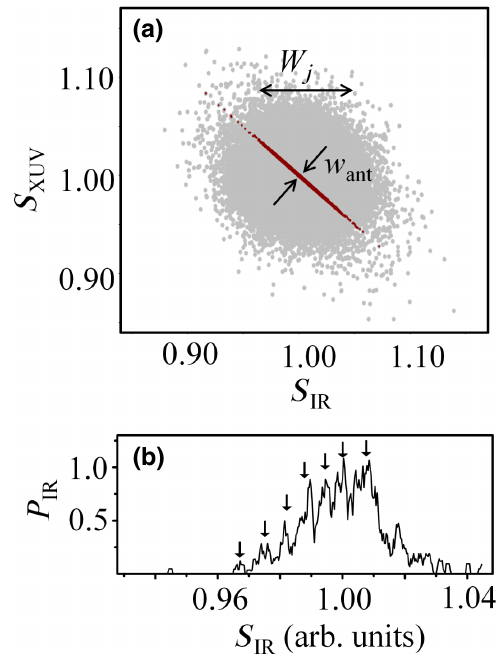
FIG. 13. (a) ( S XUV , S IR ) photon-number distribution (gray points). The mean values of S XUV and S IR are normalized to 1. Here W j shows the width of the distribution. The red points show the selected points along the anticorrelation diagonal of width w ant . The distribution is created by keeping the energy stability of the driving field at the level of approximately 1%, and after subtracting the electronic noise from each laser shot. (b) Proba- bility of absorbing IR photons ( P IR ) towards HHG. The arrows depict the positions of the peaks in the multipeak structure of P IR . Figure reproduced from Ref.